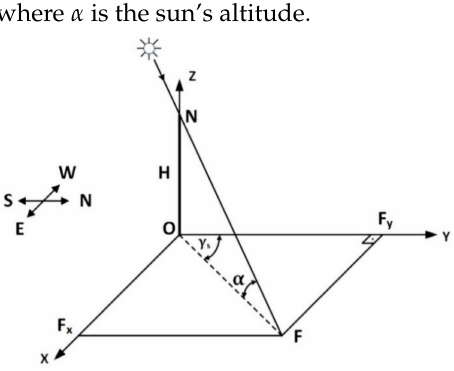
Figure 2. Shadow components of line ON .